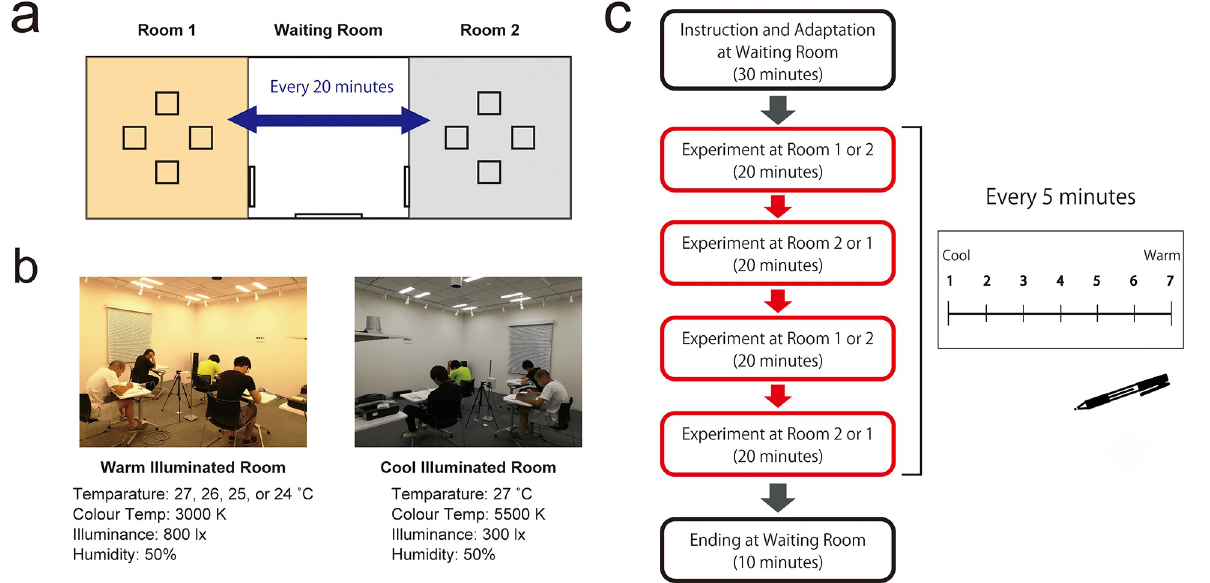
Fig 1. Design and procedure of the main experiment. (a) Experimental Rooms (Meta-comfort Lab, Kyoto, Japan): there were three rooms with no windows: two experimental rooms, and one waiting room. (b) Pictures of warm and cool illuminated rooms and environmental parameters of each experimental room. (c) Experimental design: participants entered and stayed in Room 1 or 2 for 20 minutes. In the room, they reported their sensation of coolness/warmness every 5 minutes. Then, they moved to Room 2 or 1, stayed for 20 minutes, and made the same report as last. The same experiment was conducted on them